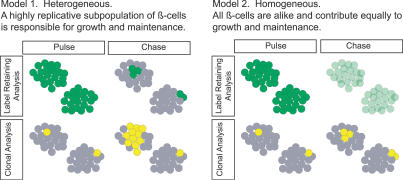
Two Possible Models for the Growth and Maintenance of Pancreatic β Cells Are Predicted, Given the Lack of an External Stem Cell PoolTwo approaches were used to study replication of β cells. Pulse–chase analysis follows the loss of the H2BGFP label (green) with β cell division, while clonal analysis follows the generation of (yellow) clones from individual β cells. Model 1: the β cell population is heterogeneous, composed of fast- and slow-dividing subpopulations. This model predicts that highly replicative β cells will lose the H2BGFP label quickly and generate large clones, while slowly dividing β cells will fail to dilute the H2BGFP label and generate small clones. Model 2: the β cell population is homogeneous, and all β cells divide at the same rate. This model predicts that all β cells will lose the H2BGFP label uniformly, and that all clones identified through clonal analysis will be of comparable size.